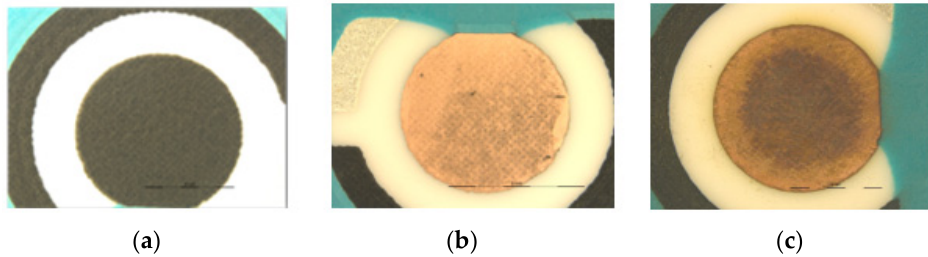
Figure 2. Screen-printed electrodes ( a ) carbon printed electrode—before copper electrodeposition; ( b ) copper-based electrode—before oxidation step; ( c ) copper oxide electrode.